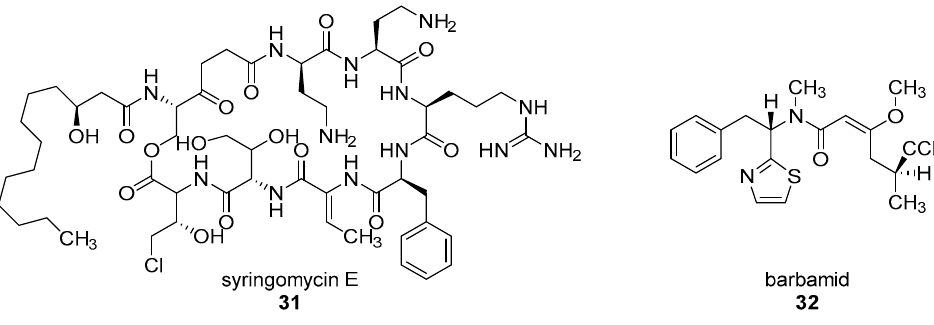
Figure 16. Proposed mechanism for halogenation reaction by Fe(II) / α KG-dependent halogenase via a radical C-H functionalization [142]. The highly reactive Fe(IV)-oxo (haloferryl) intermediate is produced by decarboxylation of α KG to succinate through an oxygen attack. Subsequently abstraction of a hydrogen-atom from the substrate leads to an energetically favourable rearrangement towards Fe(III). Rebound reaction with chloride was shown to depend on the distance and orientation of the substrate [143]. The catalytically cycle is re-established by the hexa-coordinated Fe(II) with water molecules, chloride and histidine. Molecules 2019 , 24 , x FOR PEER REVIEW 22 of Table 4. Examples of heterologously expressed Fe(II)/ α KG-dependent halogenases.